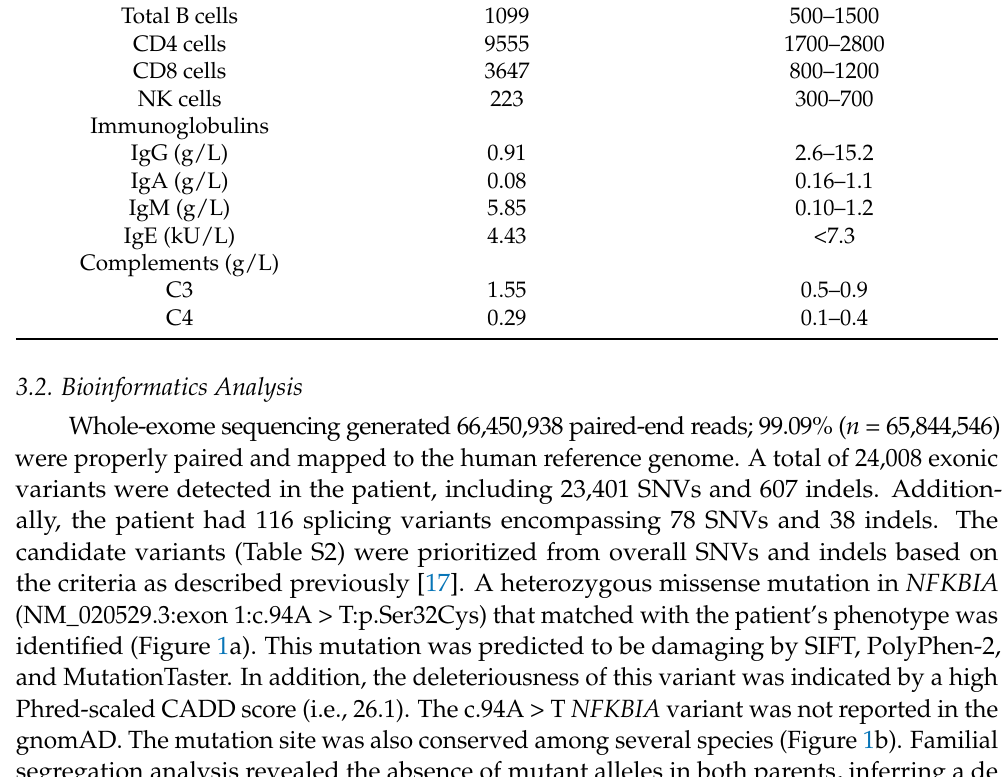
Table 1. Immunological parameters of the study subject. Immunological Parameters Result Reference Range Lymphocyte subsets (Absolute count, × 10 6